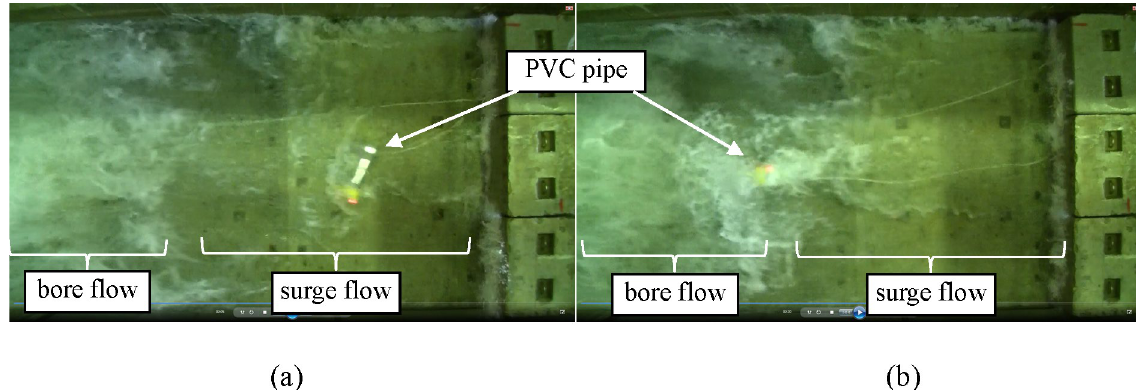
Fig 5. Frame recorded from the top view (PVC pipe): (a) initially lying (b) initially